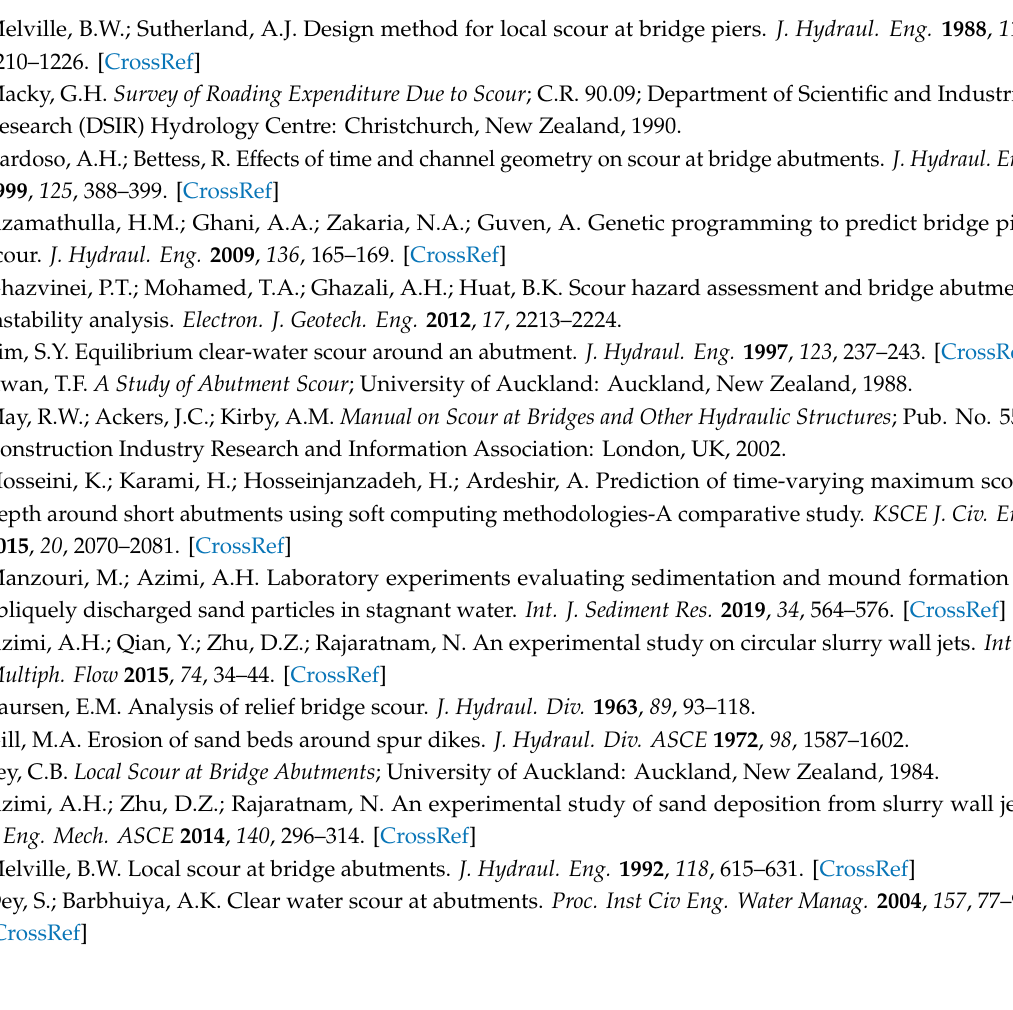
Table S1: MAPE , RMSE , R and SI values of di ff erent input combinations in abutment scour depth prediction, Table S2: Relative error (RE) values for di ff erent input combinations verified in this